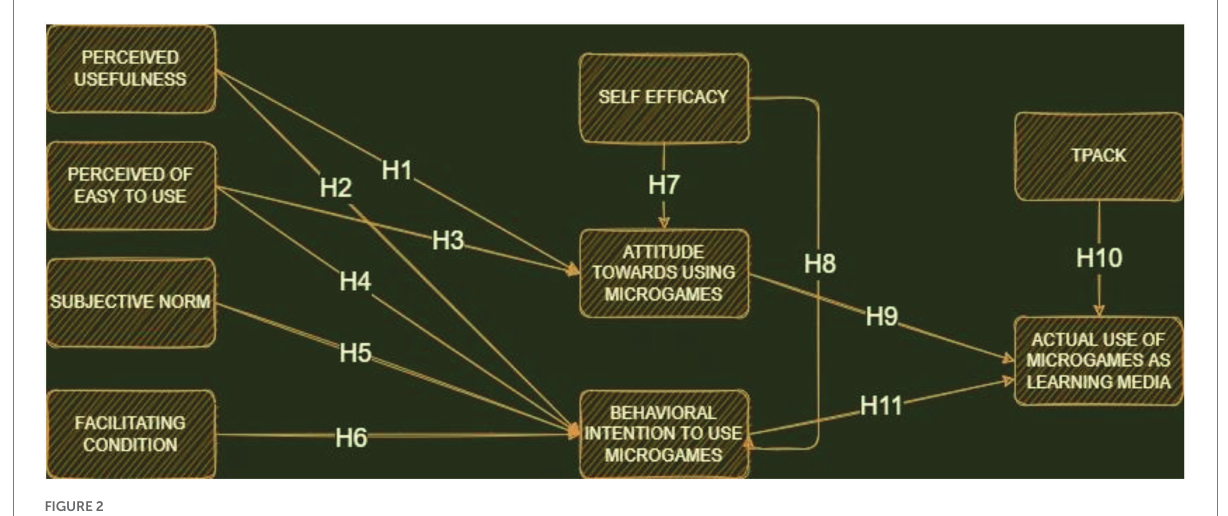
FIGURE 2 Initial hypothesis and model development.